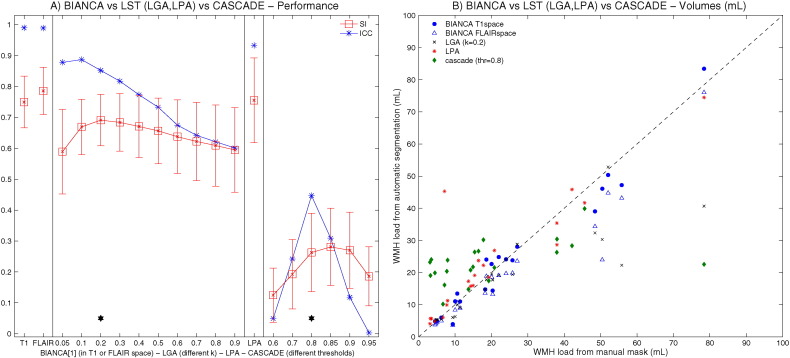
Direct comparison with available tools. Panel A shows the similarity index (SI, red), with mean value (square marker) and standard deviation (error bars) across subjects and the intra class correlation coefficient (ICC, blue) between the total WMH volume from BIANCA (in T1w or in FLAIR space), CASCADE (for different thresholds), LGA (for different kappa values, threshold 0.5) and LPA (threshold 0.5) and manual segmentation. The black star indicates the optimal options for CASCADE and LGA that were chosen for comparison against BIANCA. Panel B shows volumes calculated from BIANCA, CASCADE, LGA and LPA for each subject against the WMH load (WMH volume in mL extracted from the manual masks in the reference space used by the algorithm).